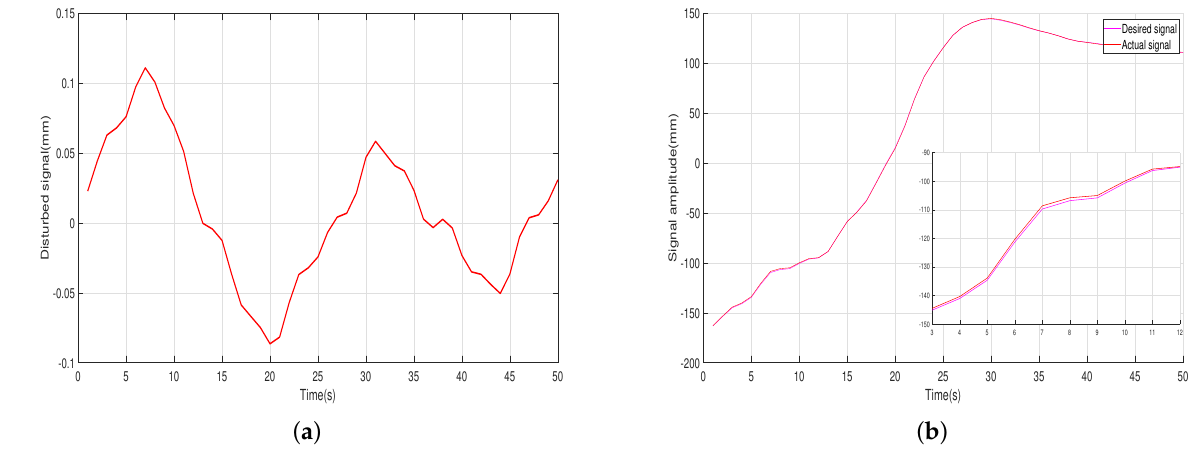
Figure 11. The trajectory with tremor and the effect of tremor. ( a ) The signal with small amplitude and high − low frequency tremors. ( b ) The desired operation trajectory and the actual operation trajectory with small amplitude and high − low frequency tremors.